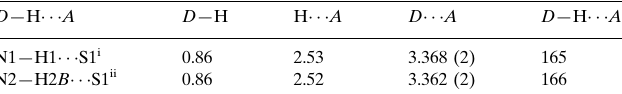
Hydrogen-bond geometry (A˚ , (cid:1)